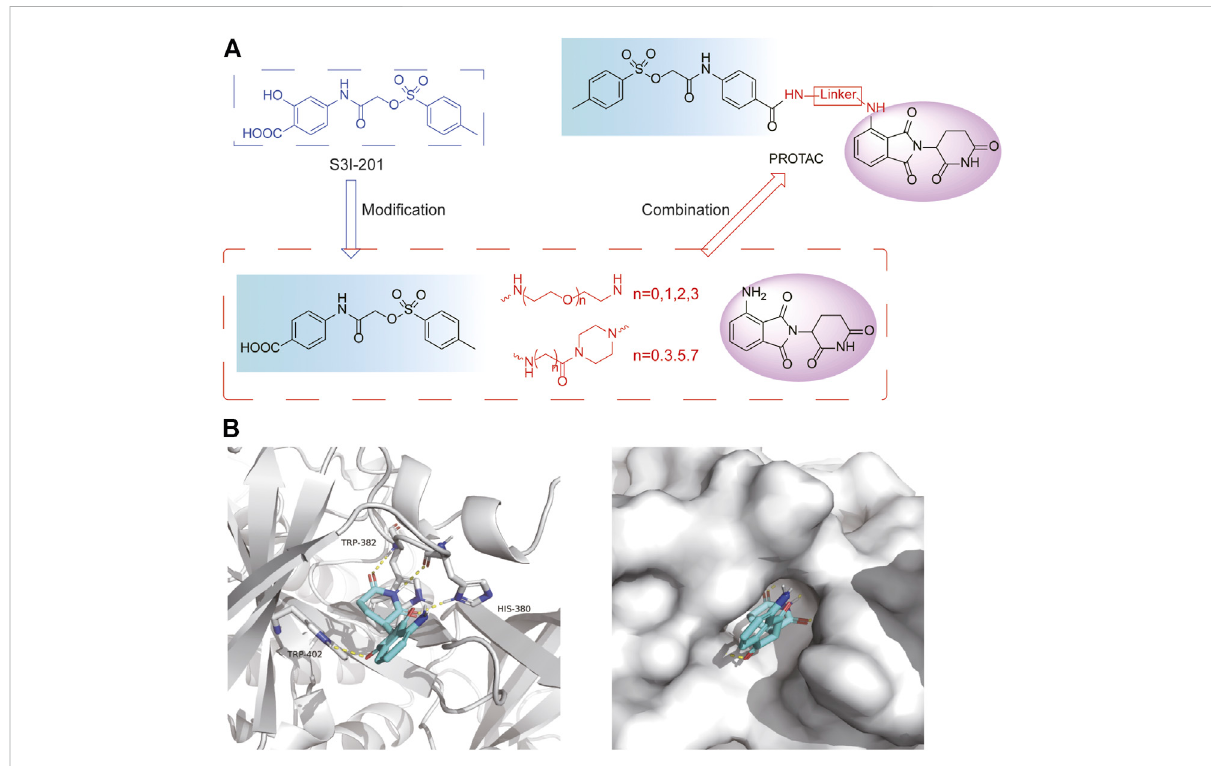
FIGURE 2 DesignideasaofPROTACs. (A) DesignideasofPROTACs.UsingS3I-201analogandpomalidomideasligands,aseriesofSTAT3PROTACswere designed by changing Linker. (B) Dockingmodel ofpomalidomide bindingto CRBN (PDB:4CI3). Pomalidomide is colored byatom typeand CRBN is represented in cartoon form. Critical residues are shown as sticks. Hydrogen bonds are represented by yellow dashed